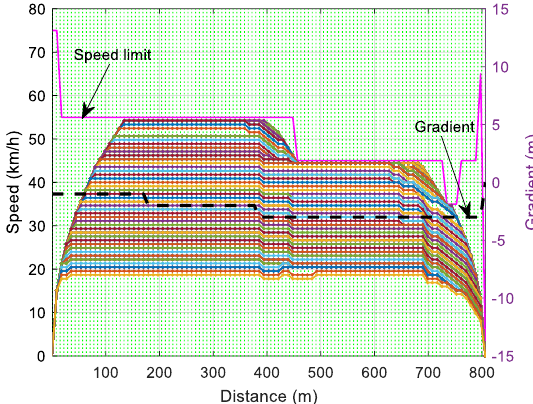
Figure 3. Speed profiles by DP with multiple weights. Table 5. Results of speed profiles obtained for multiple weights.